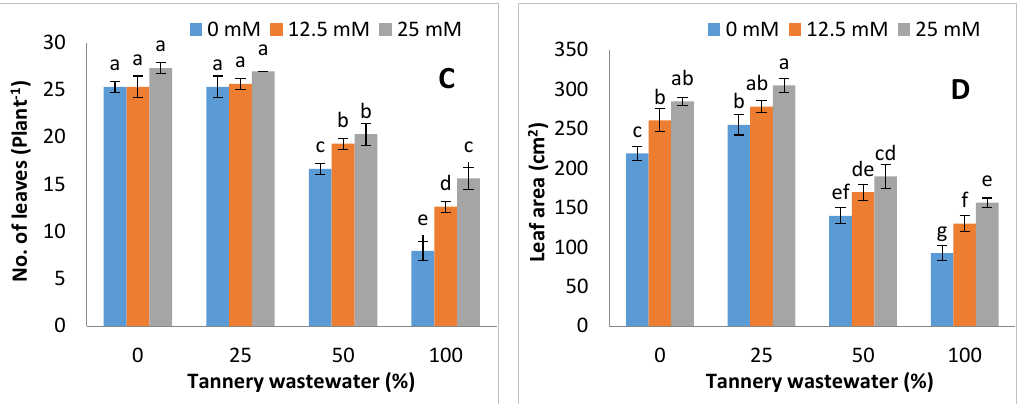
Figure 1. Graphs showing the effect of foliar spray of zinc chelated lysine (0, 12.5, 25 mM) on plant height ( A ), root length ( B ), number of leaves ( C ) and leaf area ( D ) of maize plants growing under 0, 25, 50, and 100% concentration of tannery wastewater. Values are means of three replicates. Statistical analyses were carried out by ANOVA, followed by Tukey’s Post-Hoc test.